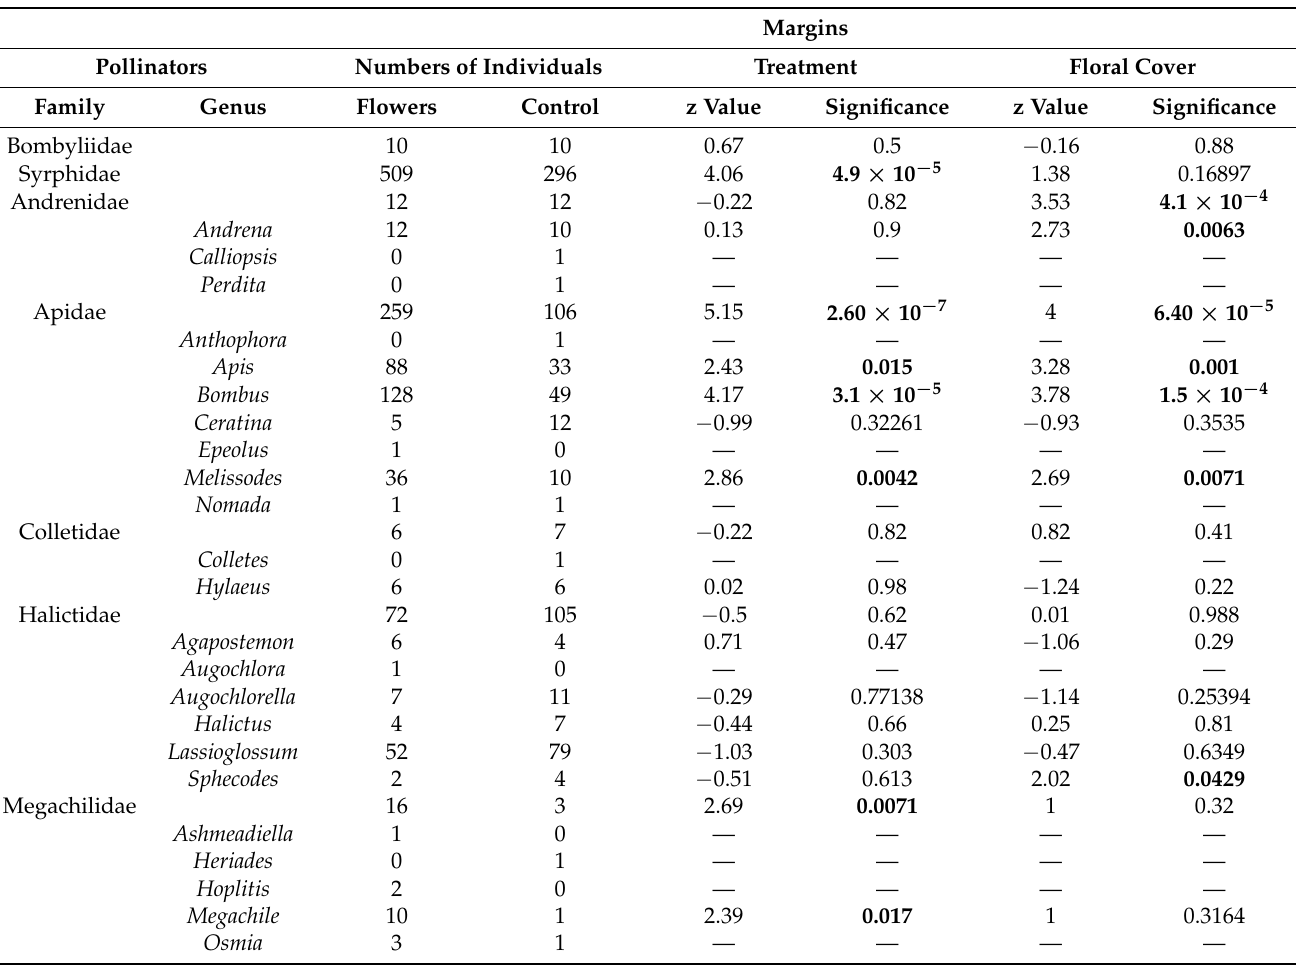
Figure 3. Effect of floral cover on pollinator abundance in ( a ) field margins and ( b ) potato crops. Shaded area represents 95% confidence interval.